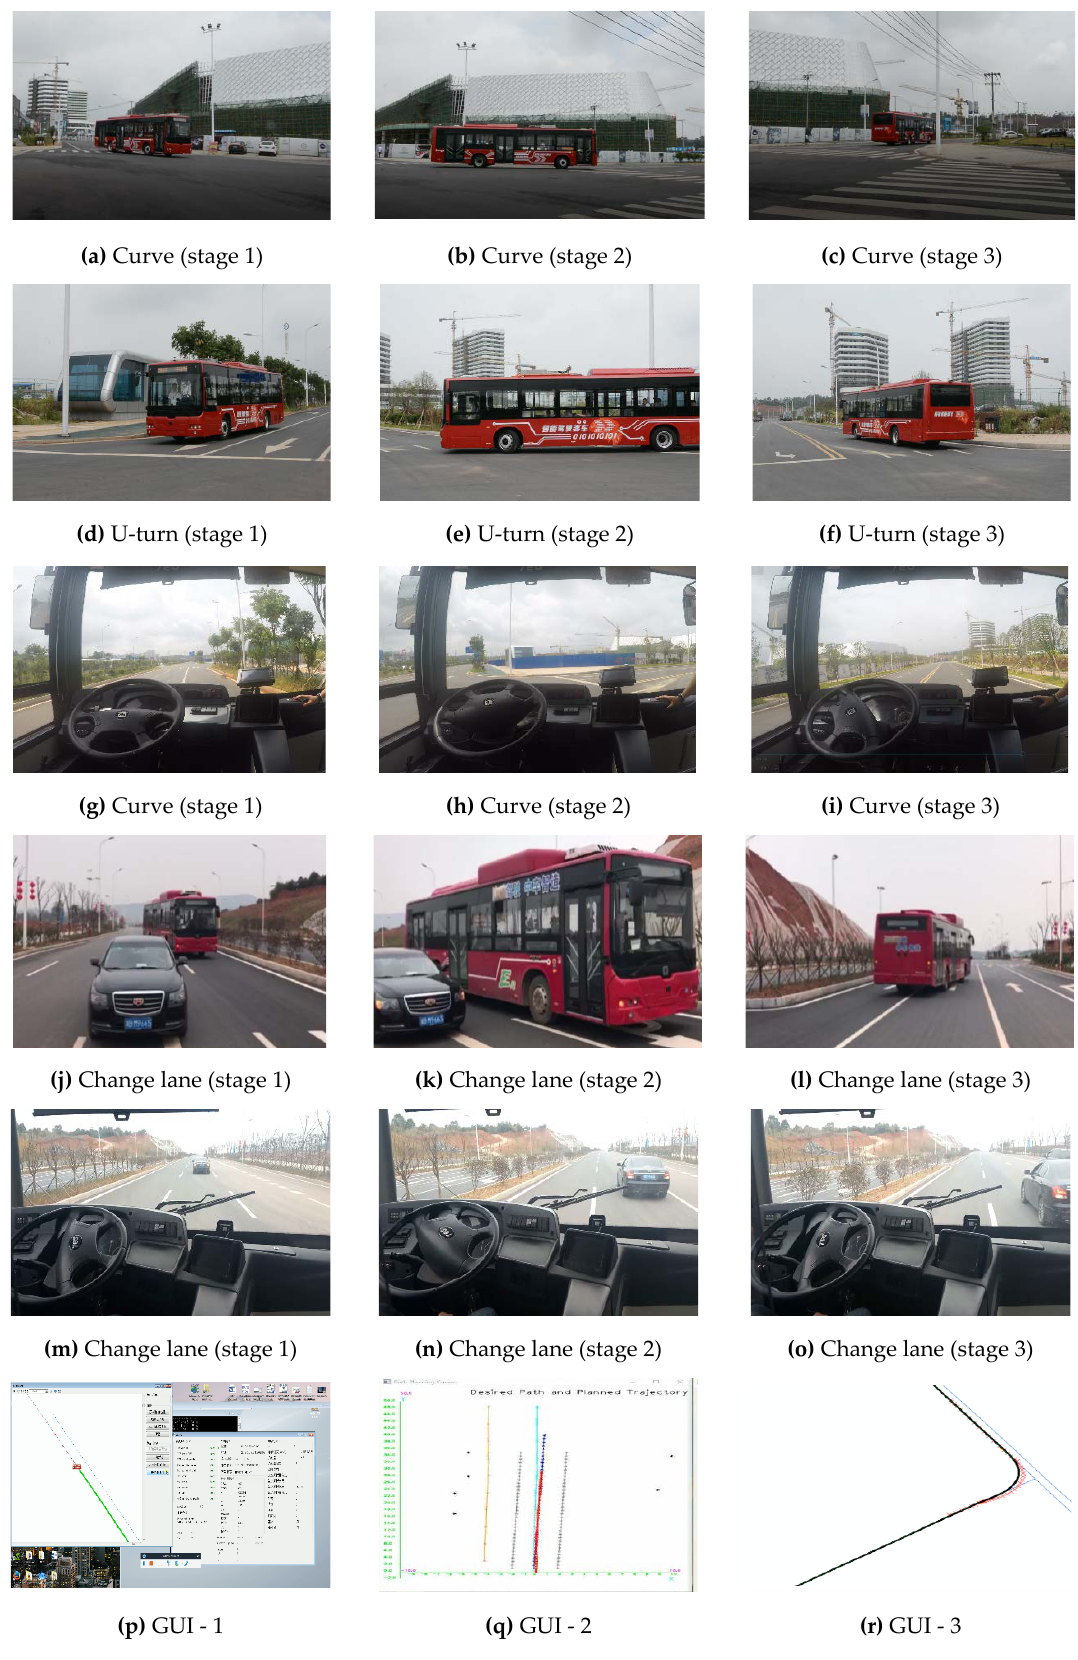
Figure 14. Experimental results of the real vehicle.